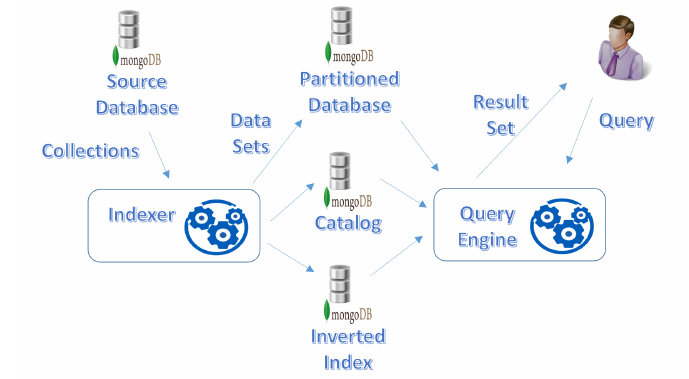
Figure 3. Retrieval approach on top of JSON Document Stores implemented in the HamerJDB